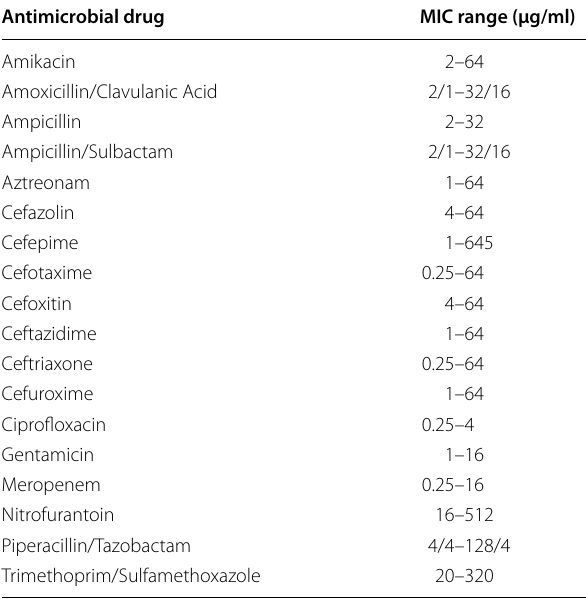
Table 1 MIC ranges (µg/ml) of the antibiotics used by Vitek 2 Compact AST GN83 cards Antimicrobial